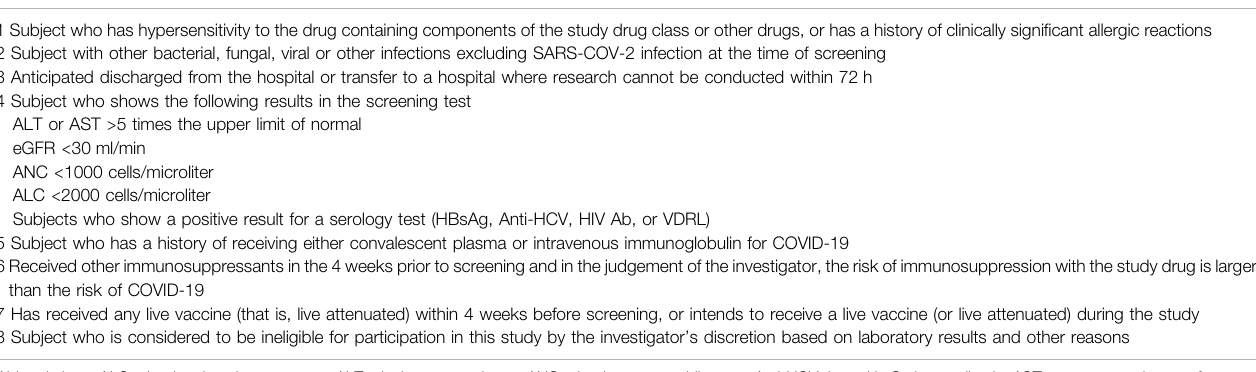
TABLE 4 | Examples of exclusion criteria for a study design of an anti-in fl ammatory agent for